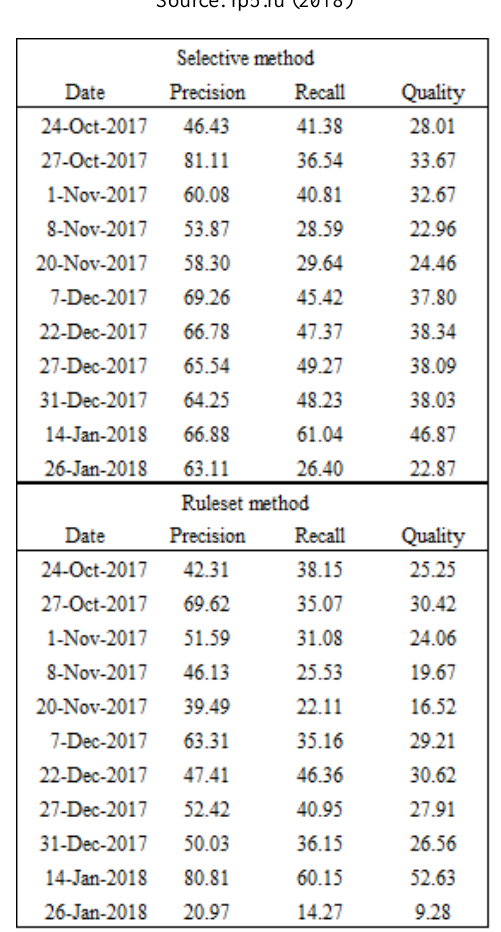
Table 3. Season 2017/18: validation results